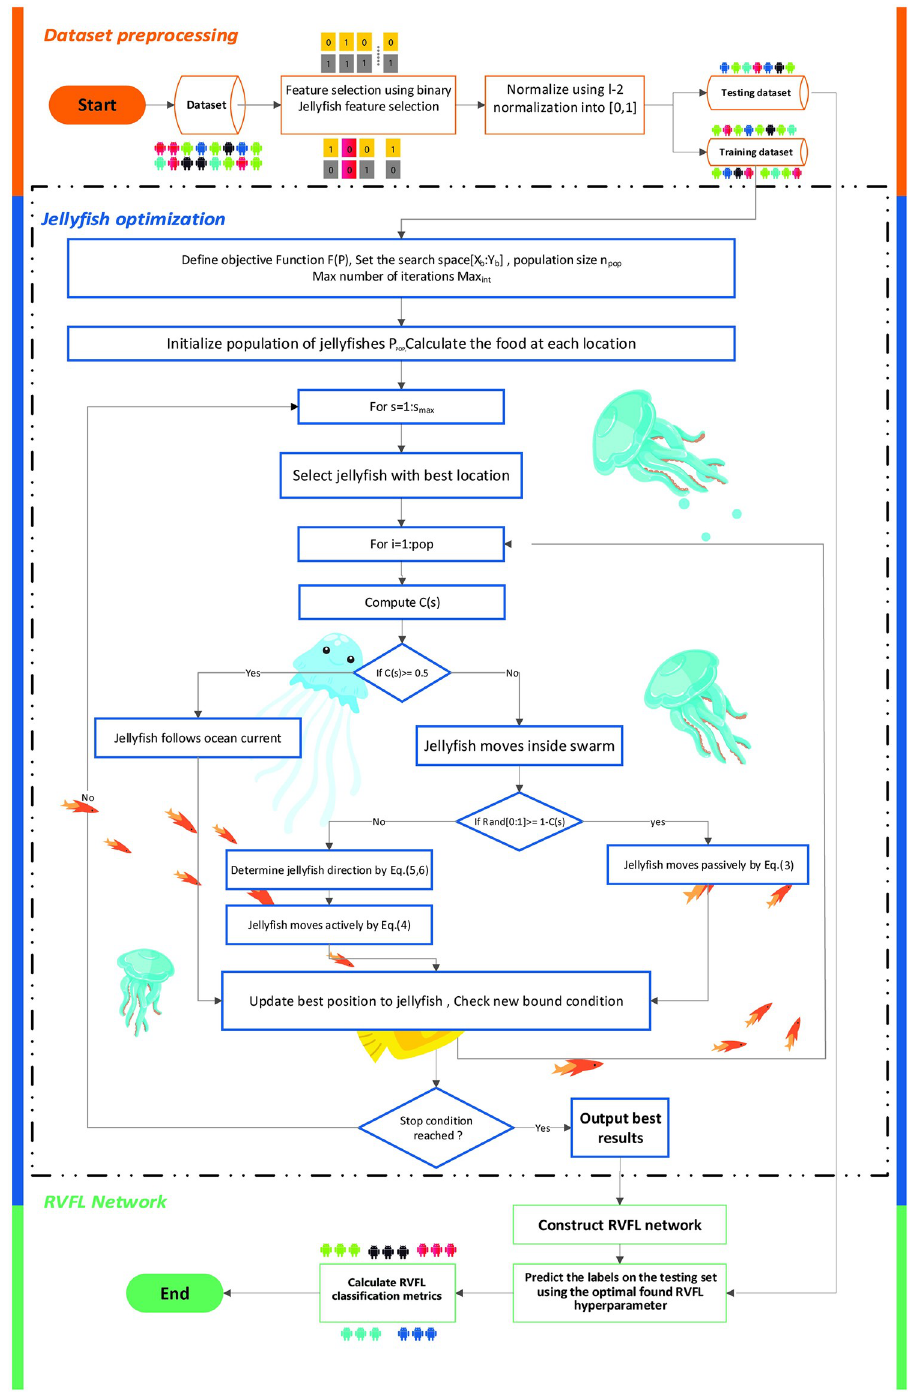
Fig 2. Proposed randomized vector functional link plus artificial jellyfish swarm model.